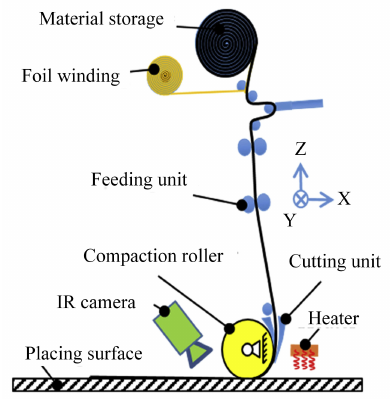
Figure 1. The principle of AFP